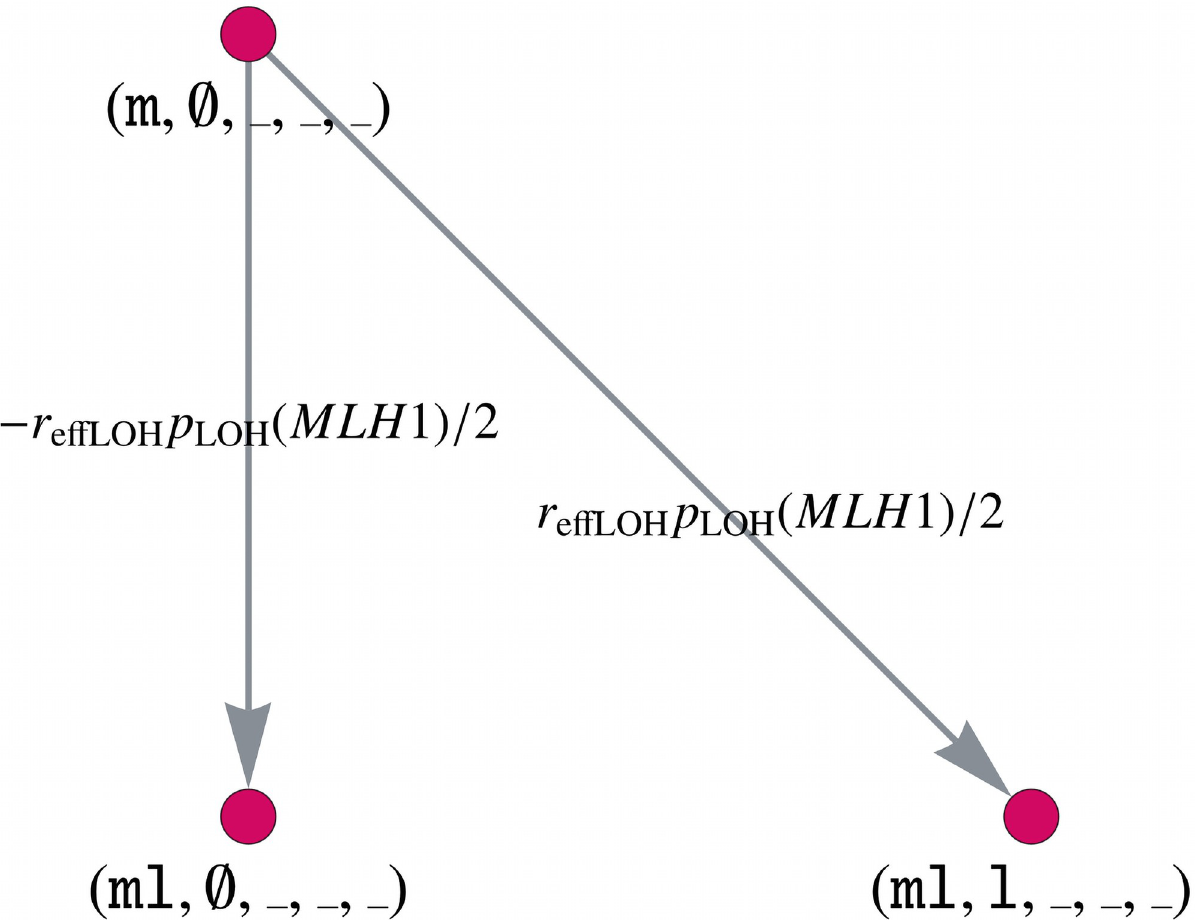
Fig 5. Model component for the positive association of MLH1 and CTNNB1 . Part of the combined gene mutation graph for CTNNB1 and MLH1 of the matrix C . The gene mutation graphs for the other possible gene states MLH1 2 { l , ll }, CTNNB1 2 { m , ml } are defined in an analogous way.